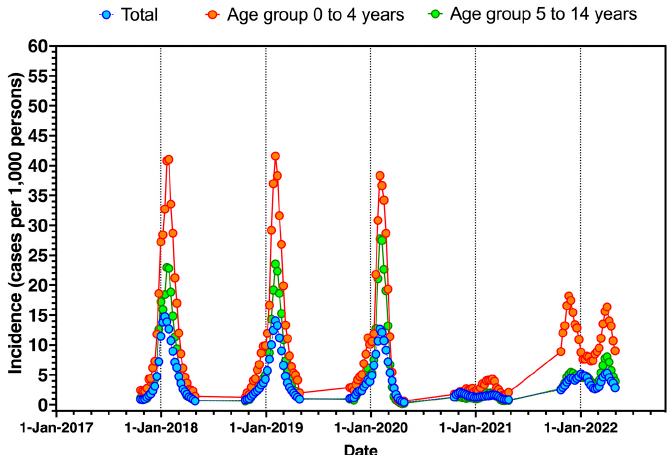
Figure 1. Seasonal trend of influenza-like illnesses (ILI) as reported by InfluNet reports (2017–2022), in general and by pediatric age groups (i.e., 0 to 4 and 5 to 14 years). Dotted lines represent 31 December of plotted calendar years.